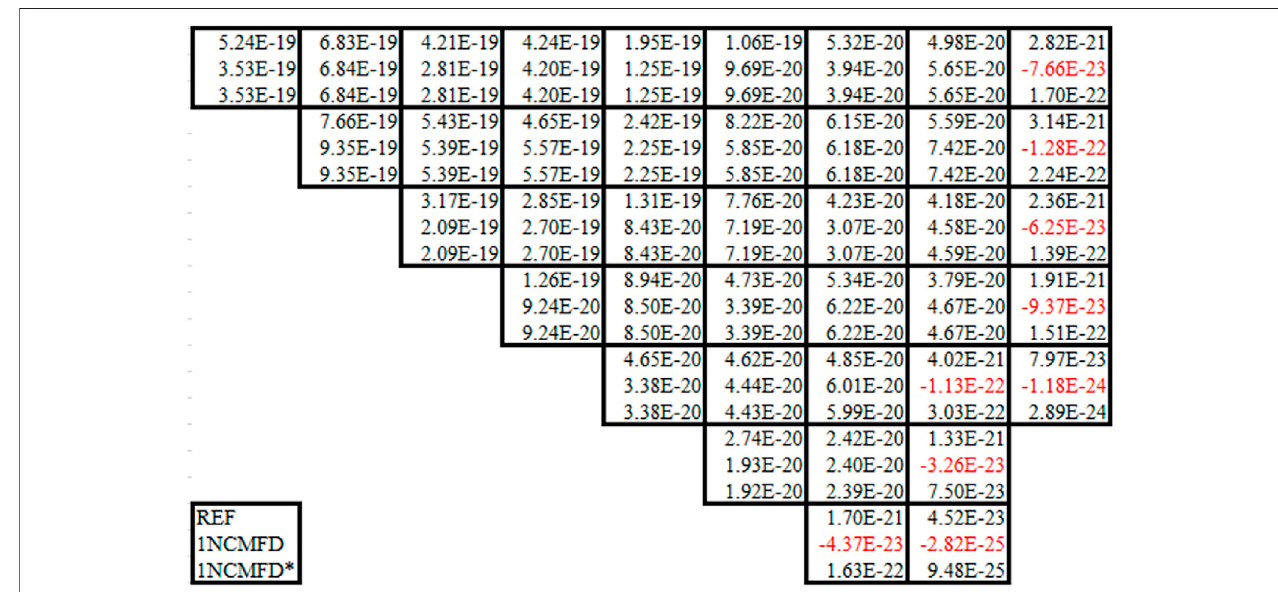
FIGURE 12 | One-node CMFD – based thermal group numerical adjoint fl ux for the KWU 2D problem. The adjusted result is denoted with an asterisk